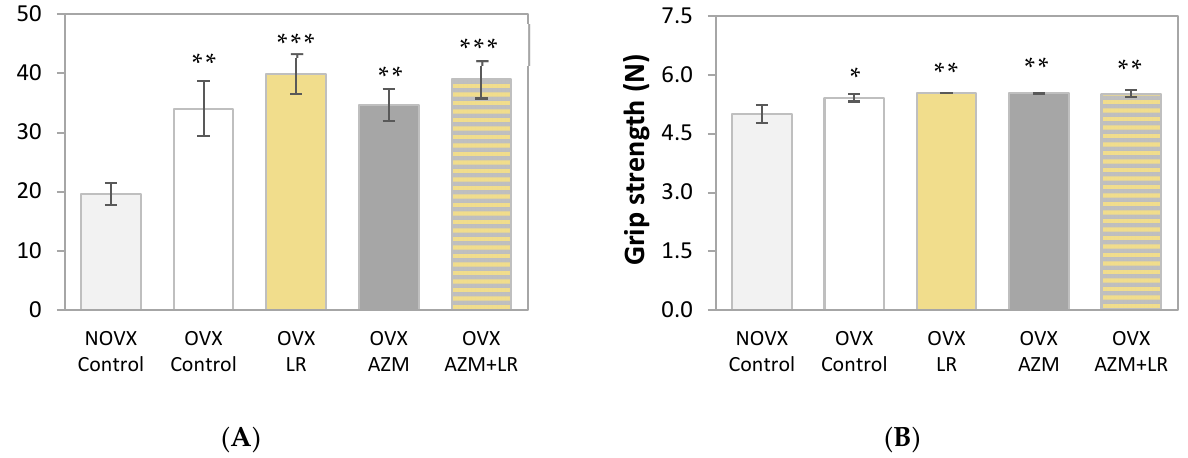
Figure 1. Effect of azithromycin (AZM) and/or Lactobacillus rhamnosus (LR) on the body mass gain ( A ) and grip strength ( B ) in ovariectomized rats. The results are presented as means ± SEM. NOVX Control—non-ovariectomized control rats; OVX Control—ovariectomized control rats; OVX LR— OVX rats treated with LR (3 × 10 8 CFU/kg daily for four weeks); OVX AZM—OVX rats treated with AZM (50 mg/kg daily in the first week and then 3 times a week for three weeks); OVX AZM + LR— OVX rats treated with AZM and LR. The body mass gain occurred during the period of the drug treatment (to the day preceding euthanasia). * p < 0.05, ** p < 0.01, *** p < 0.001—in comparison with the NOVX Control group.